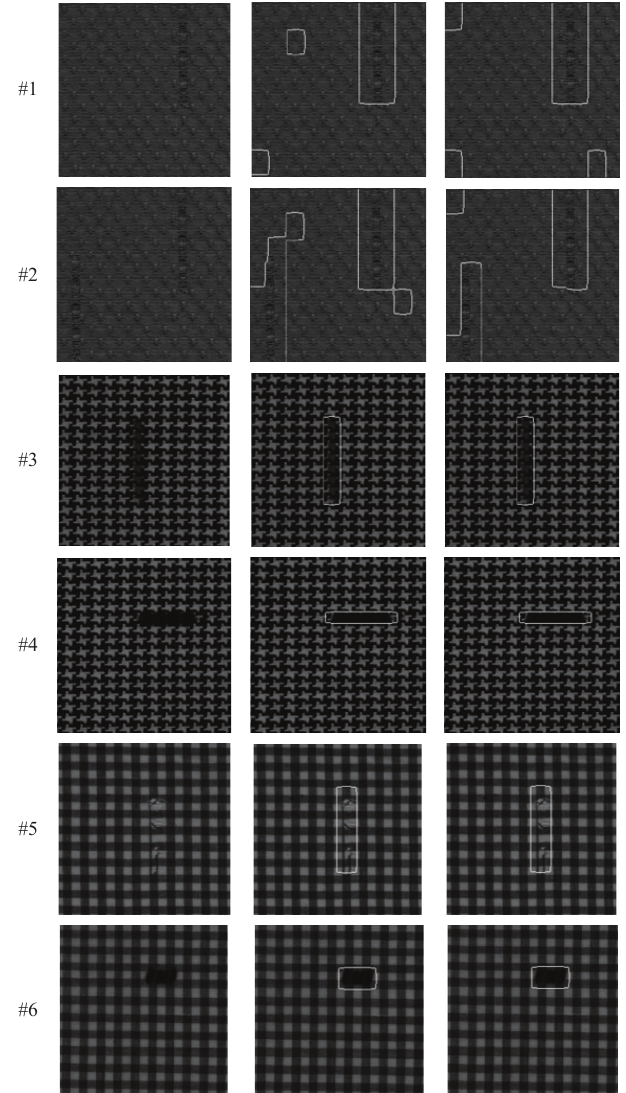
Figure 14. Final result of defect detection on sample defective fabric images: First column shows the defective fabrics; Second column shows the defect detection result based on chi-square histogram distance; Third column shows the defect detection result based on universal quality index; First and second rows indicate defective pmm images; Third and fourth rows indicate defective p2 images; Fifth and sixth rows indicate defective p4m